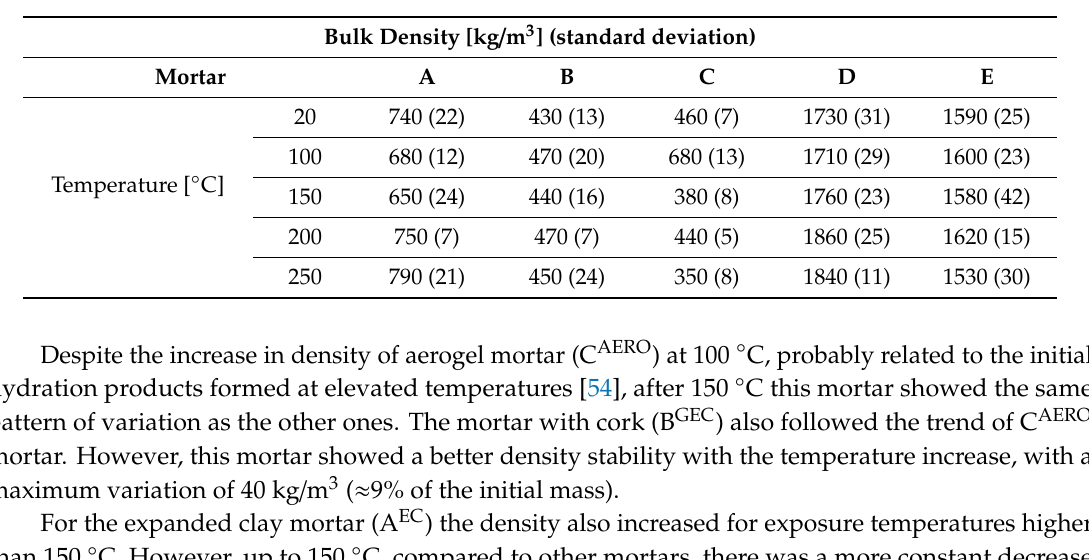
Table 2. Bulk density average vs. exposure temperature.